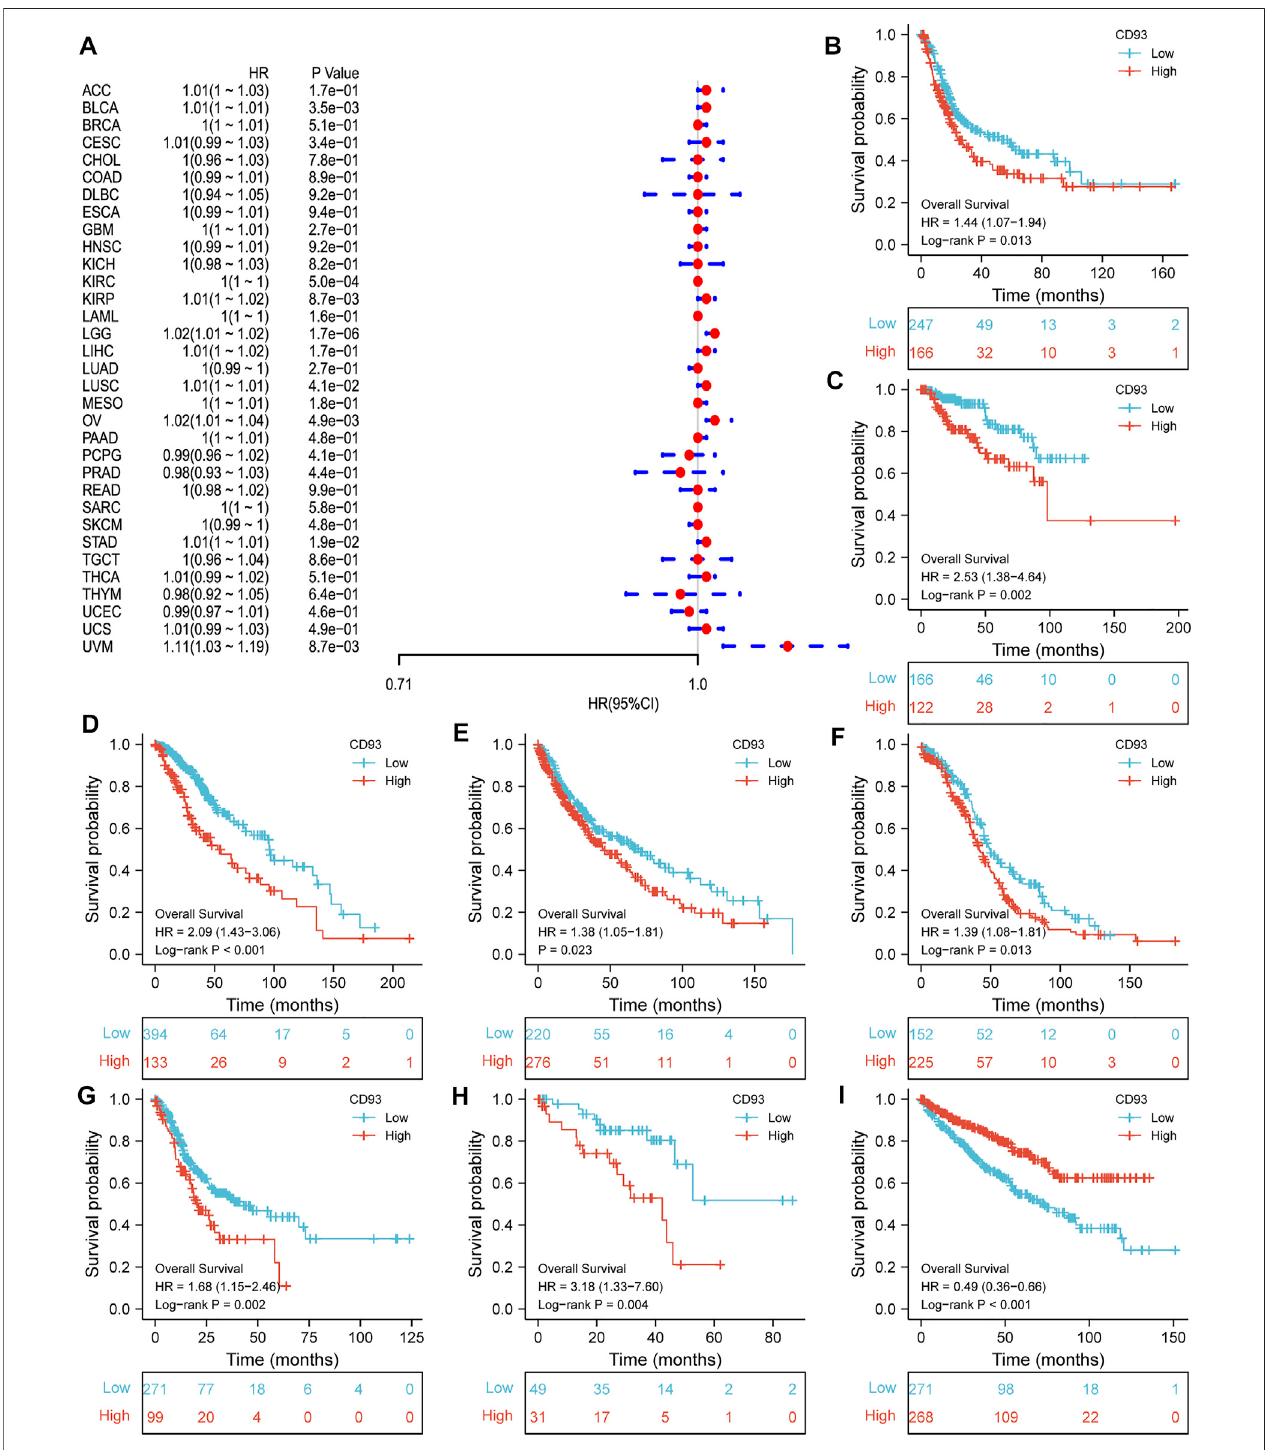
FIGURE 2 | Association between CD93 and OS. (A) Forest plot of OS associations in 33 types of tumors. (B – I) Kaplan – Meier analysis of the association between CD93 and OS in BLCA, KIRP, LGG, LUSC, OV, STAD, UVM, and KIRC.